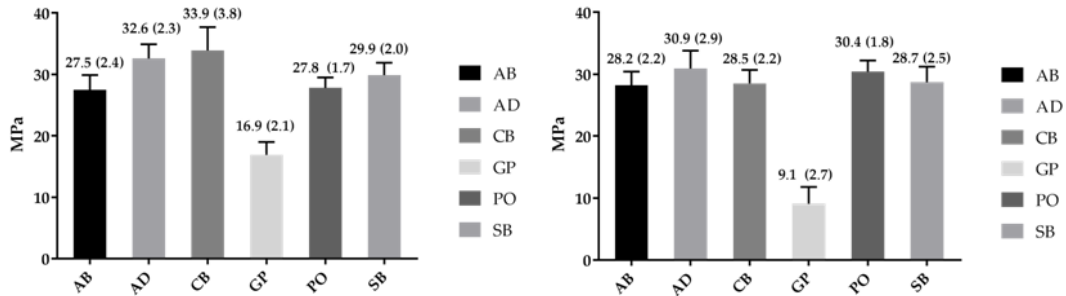
Figure 3. Mean values and standard deviations for shear bond strength to polished Co-Cr alloy before ( left ) and after alumina-blasting ( right ).